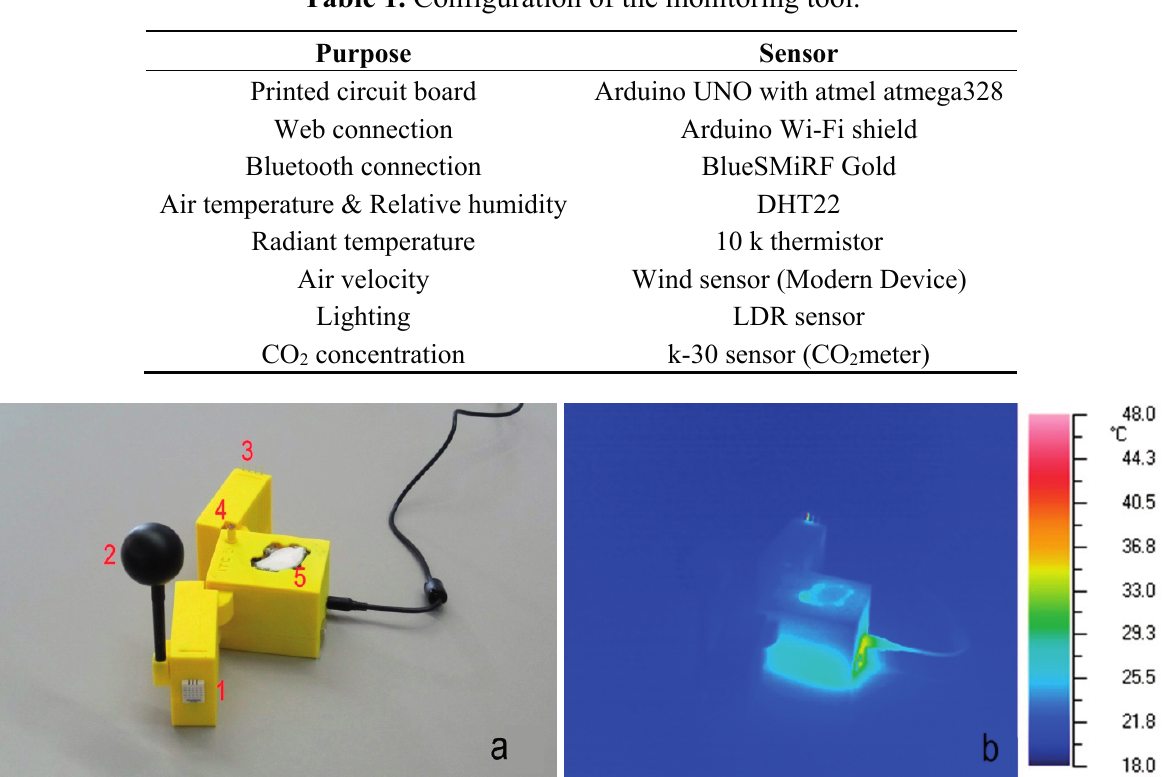
Table 1. Configuration of the monitoring tool.